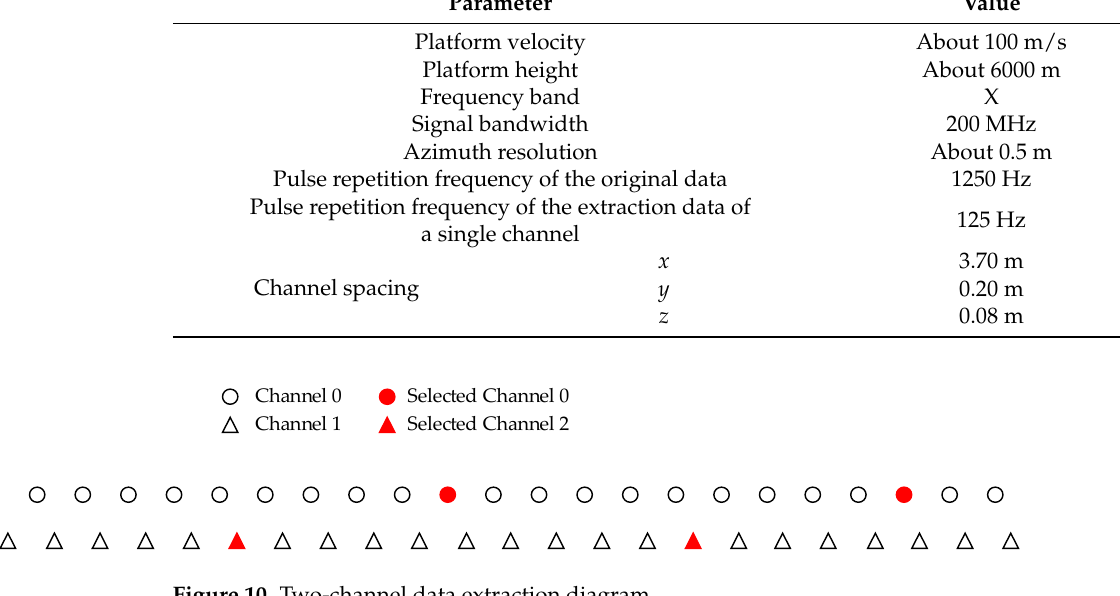
Figure 10. Two-channel data extraction diagram.